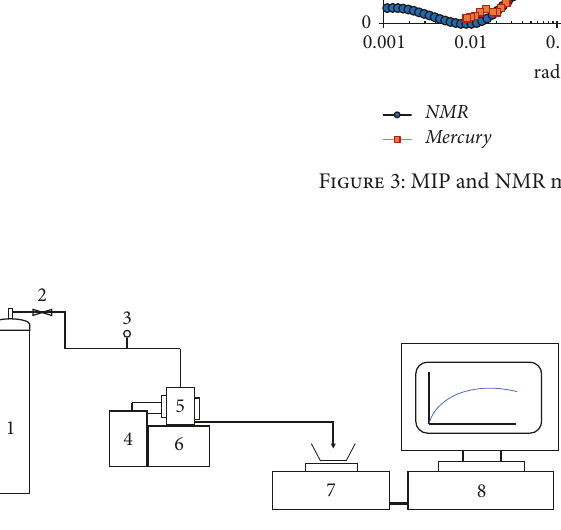
Figure 4: A schematic diagram of the frontal filtration